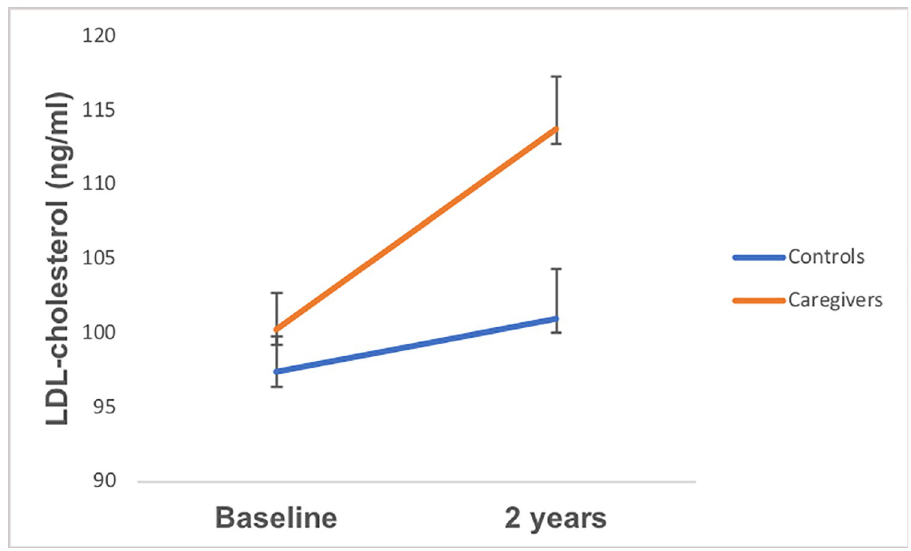
Fig 3. Group differences in LDL-cholesterol change from baseline to 2 years, adjusting change in BMI from baseline to 2